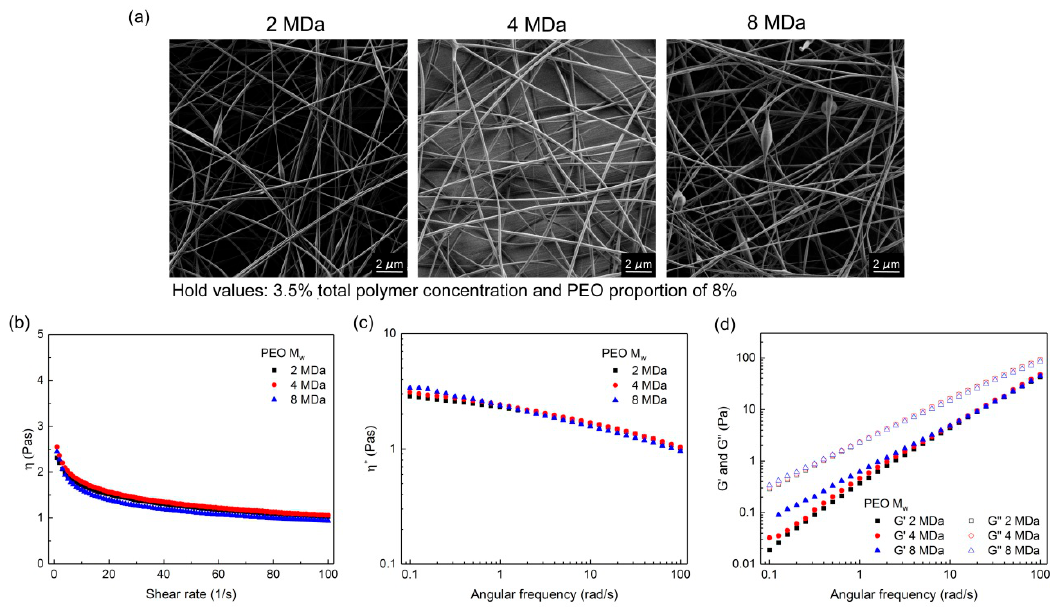
Figure 2. ( a ) scanning electron microscopy images of nanofibers obtained from the polymer-blend solutions and three different PEO M w (as indicated), with 3.5% total polymer concentration and PEO proportion of 8%; ( b – d ) corresponding viscosities ( η ) ( b ); complex viscosities ( η * ) ( c ); and storage ( G’ ) and loss ( G” ) moduli ( d ).